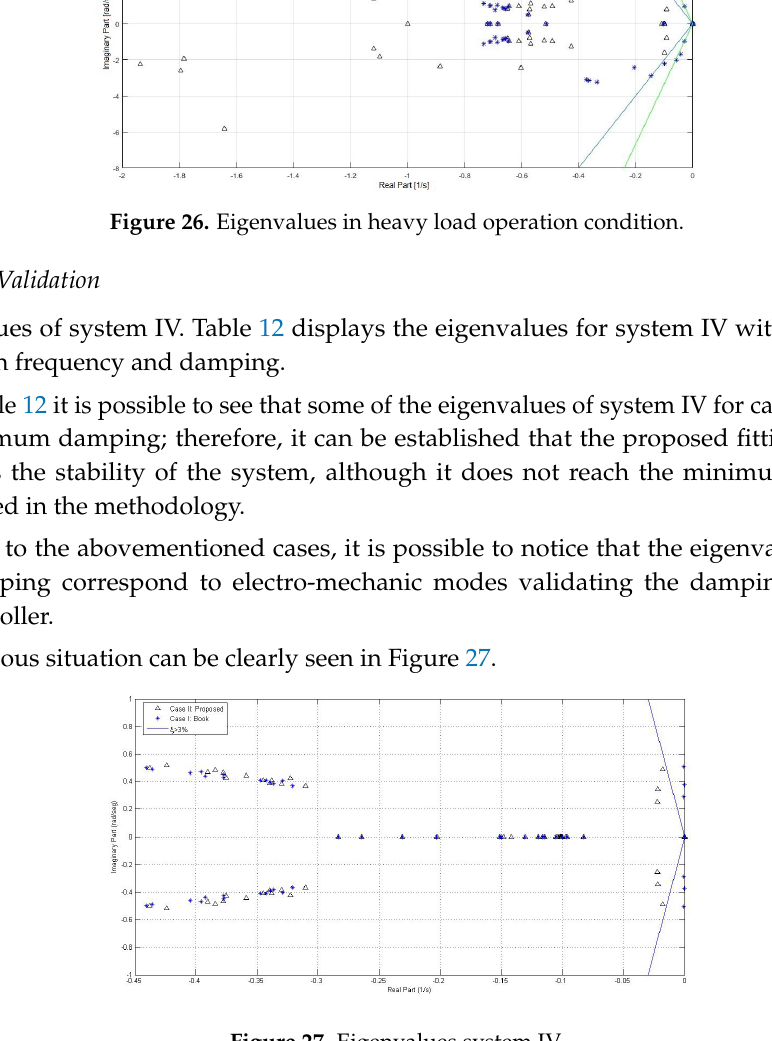
Figure 27. Eigenvalues system